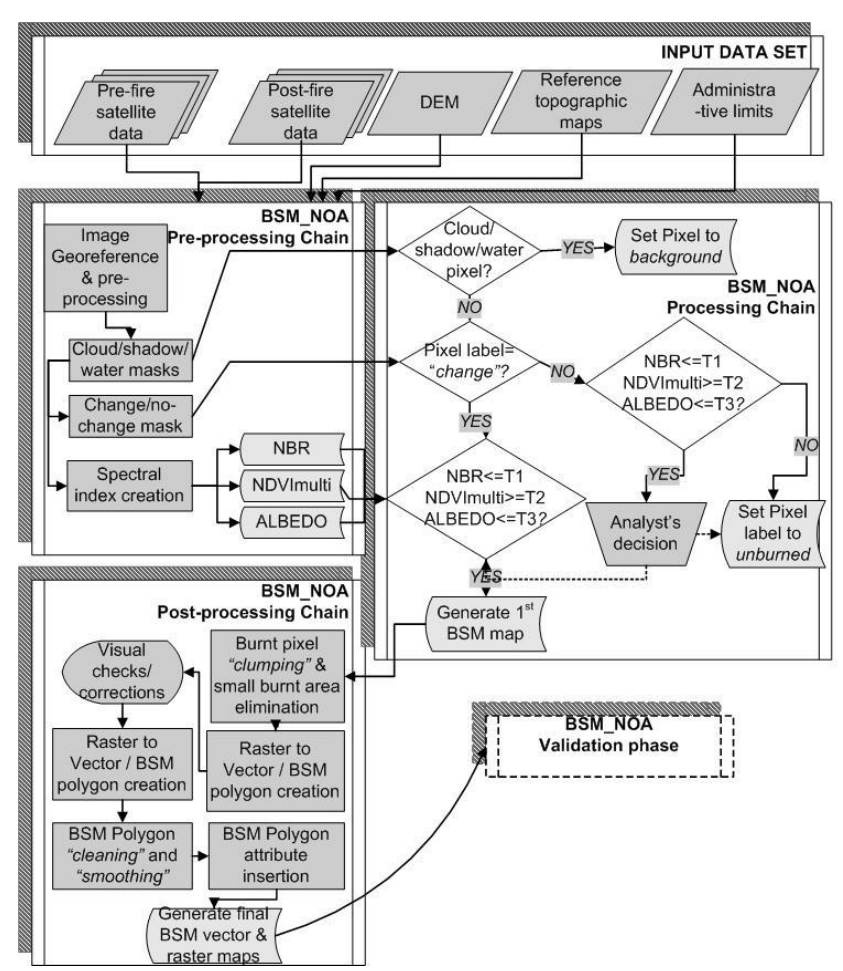
Figure 2. The BSM_NOA processing chain (source: